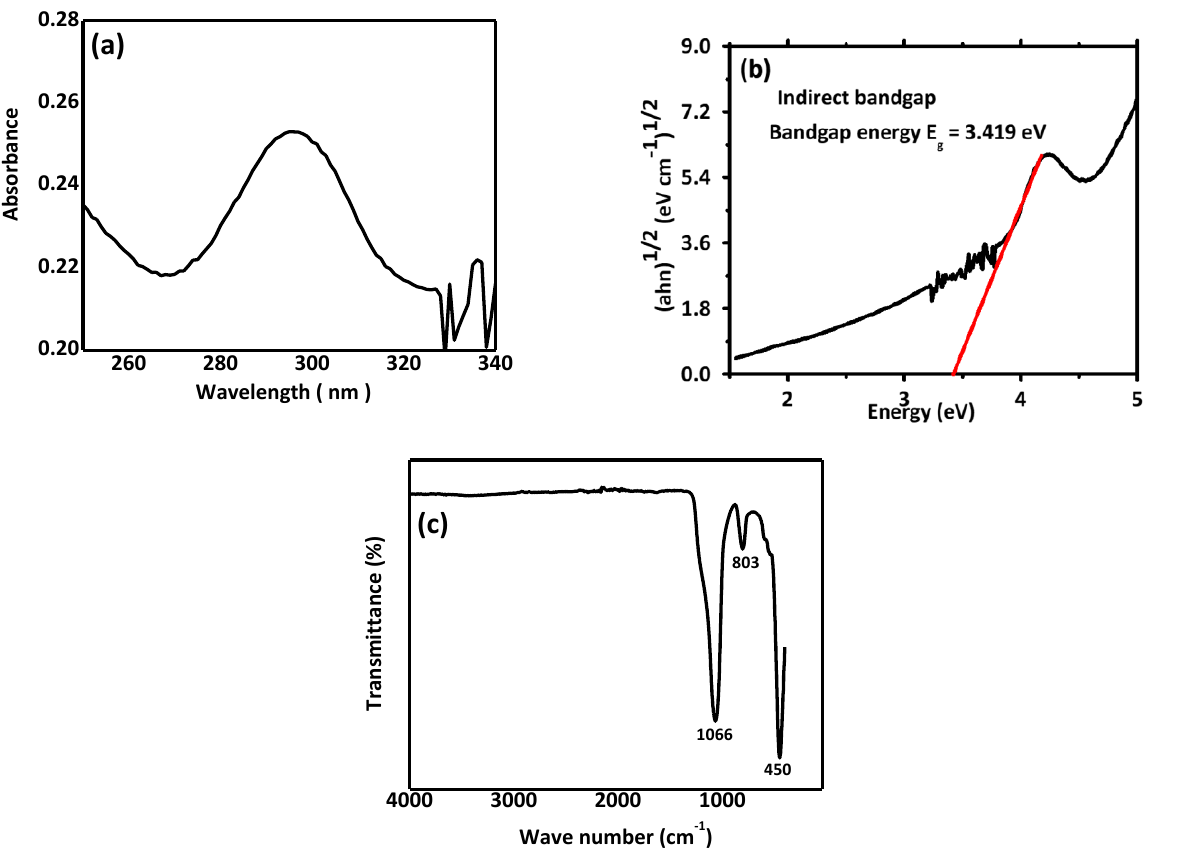
Figure 1. ( a ) UV − Visible spectrum, ( b ) Taucs plot for bandgap calculation and ( c ) FT-IR spectrum of the CuO – SiO 2 composite.